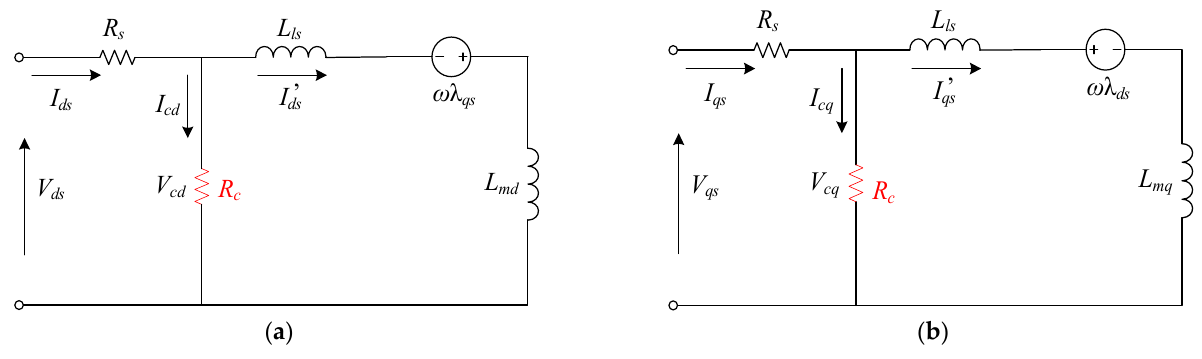
Figure 10 [19,20] presented another kind of d -and q -axis ECM of PMSMs. In this ECM, L ls is the leakage inductance per-phase, and L md and L mq are the d -axis and q -axis component of the magnetizing inductance, respectively. Figure 10 separated the d - and q -axis inductances into magnetizing inductances and leakage inductances, and both of them contribute to the core loss.